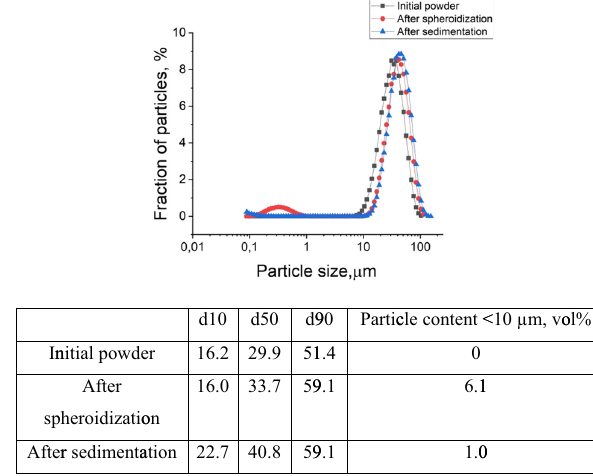
Figure 9: Granulometric composition of EI961 powder.